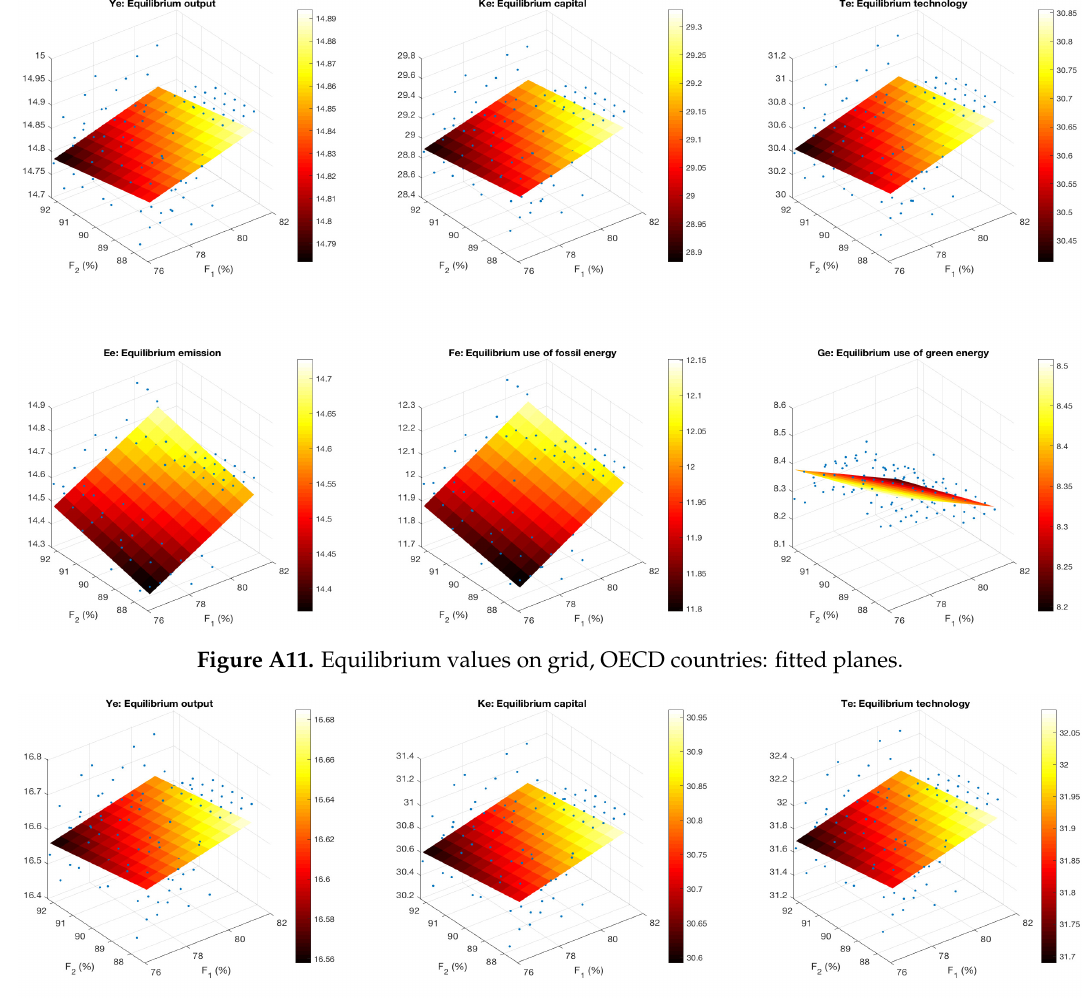
Figure A12. Equilibrium values on grid, non-OECD countries: fitted